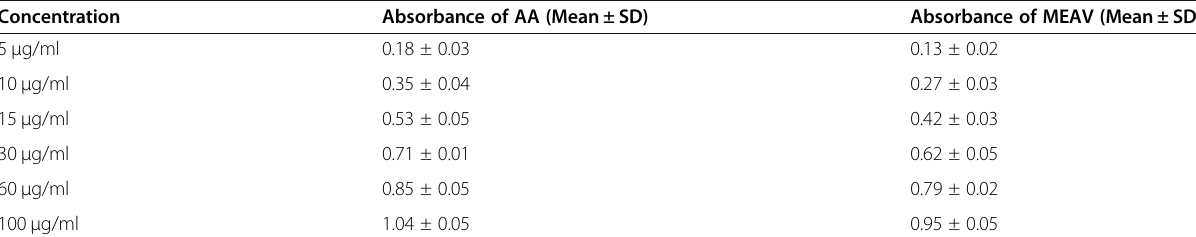
Table 3 Absorbance at different concentration of methanol extract of A. vulgaris leaves and standard ascorbic acid in reducing power